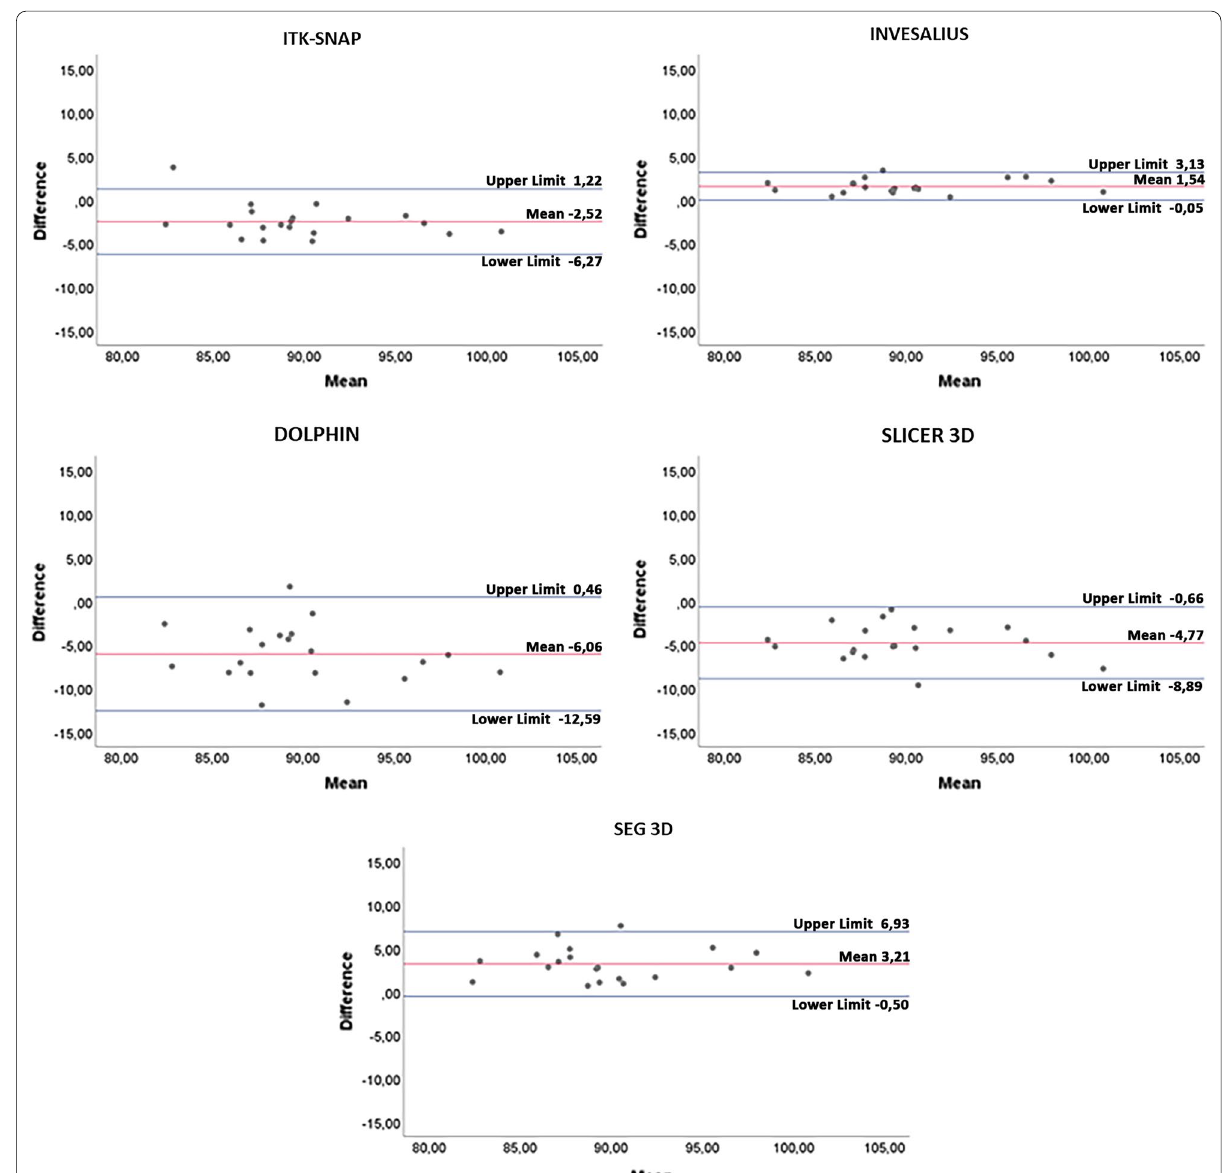
Fig. 6 Bland–Altman plot with lines of agreement between manual segmentation and semi-automatic segmentation of the upper airway